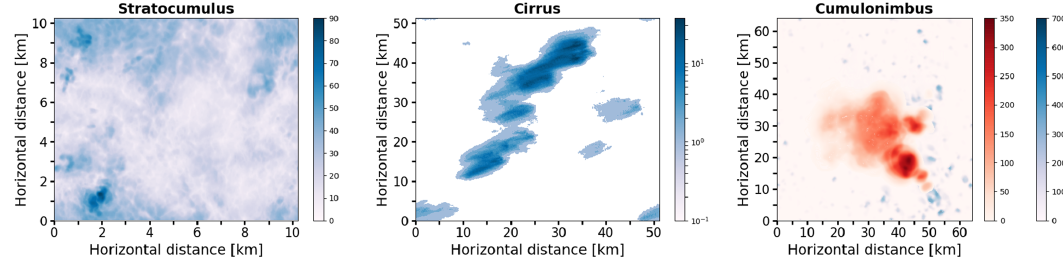
Figure 2. Vertically integrated visible optical thickness of selected cloud field case studies. Note that in the case of cumulonimbus, the blue/red shading denotes optical thickness of liquid/ice water content.